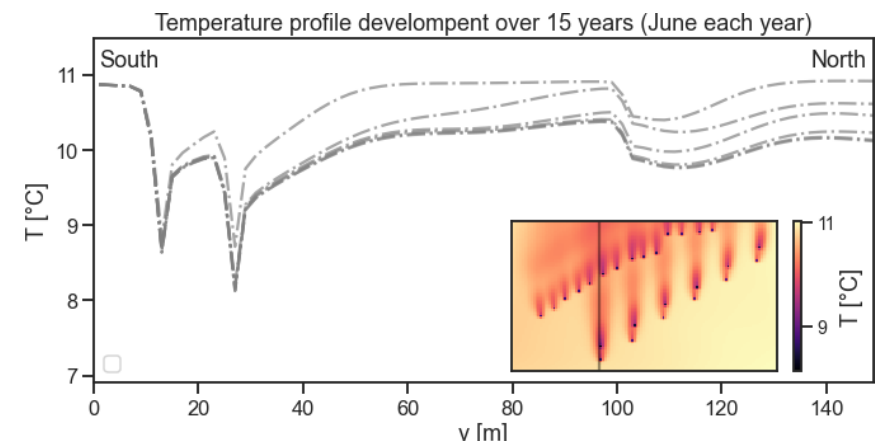
Figure 6. North South trending temperature profile for each year over a total simulation time of 15 years. Small subplot shows the location of the temperature